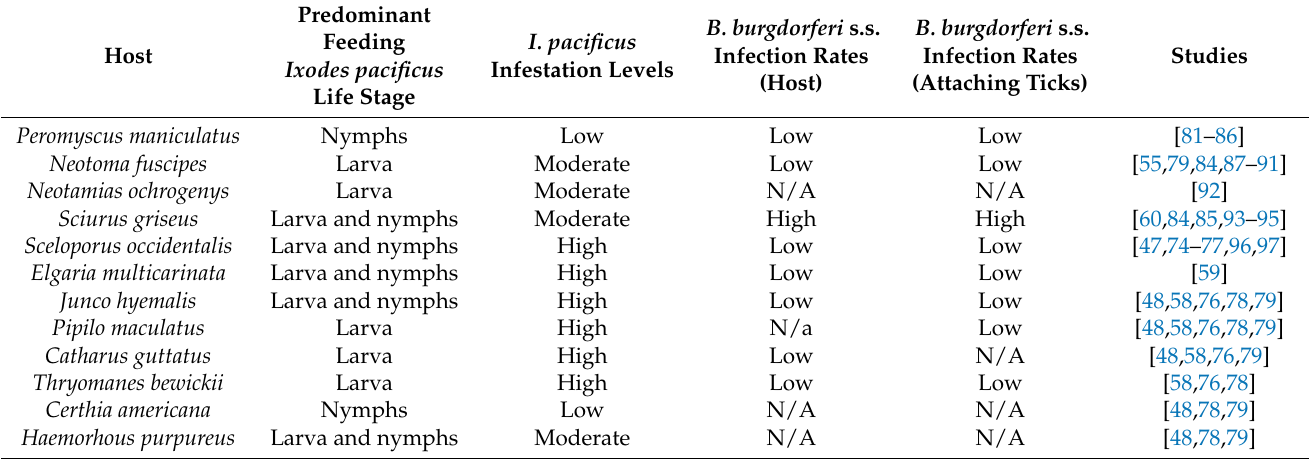
Table 1. Key and potential hosts of I. pacificus and their efficiency as reservoirs for B. burgdorferi